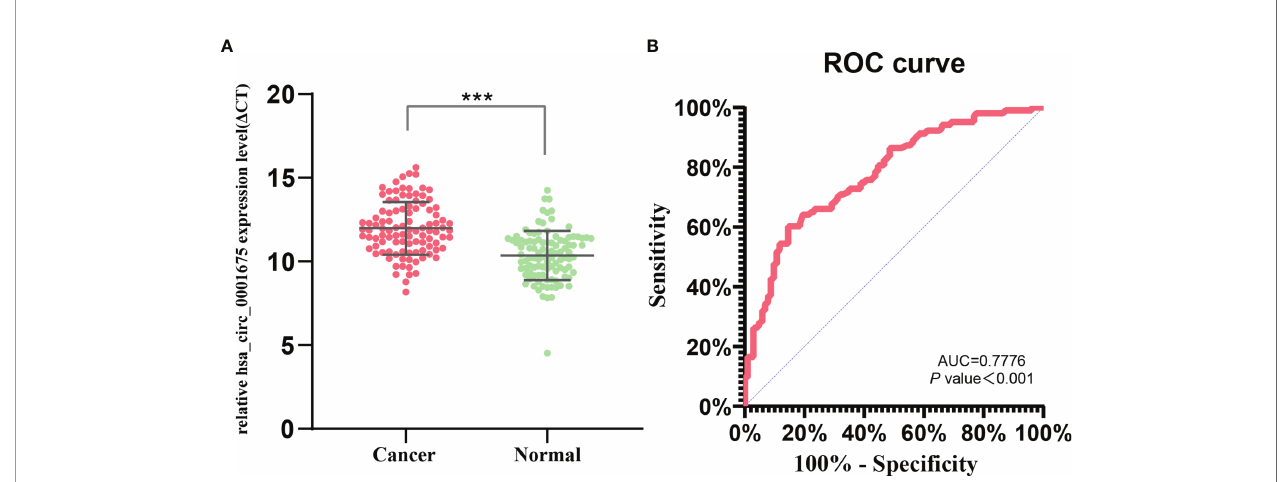
FIGURE 2 | hsa_circ_0001675 expression and diagnostic value. (A) hsa_circ_0001675 was signi fi cantly downregulated in 103 paired HNC samples. (B) Receiver operating characteristic (ROC) curve of hsa_circ_0001675. *** P <